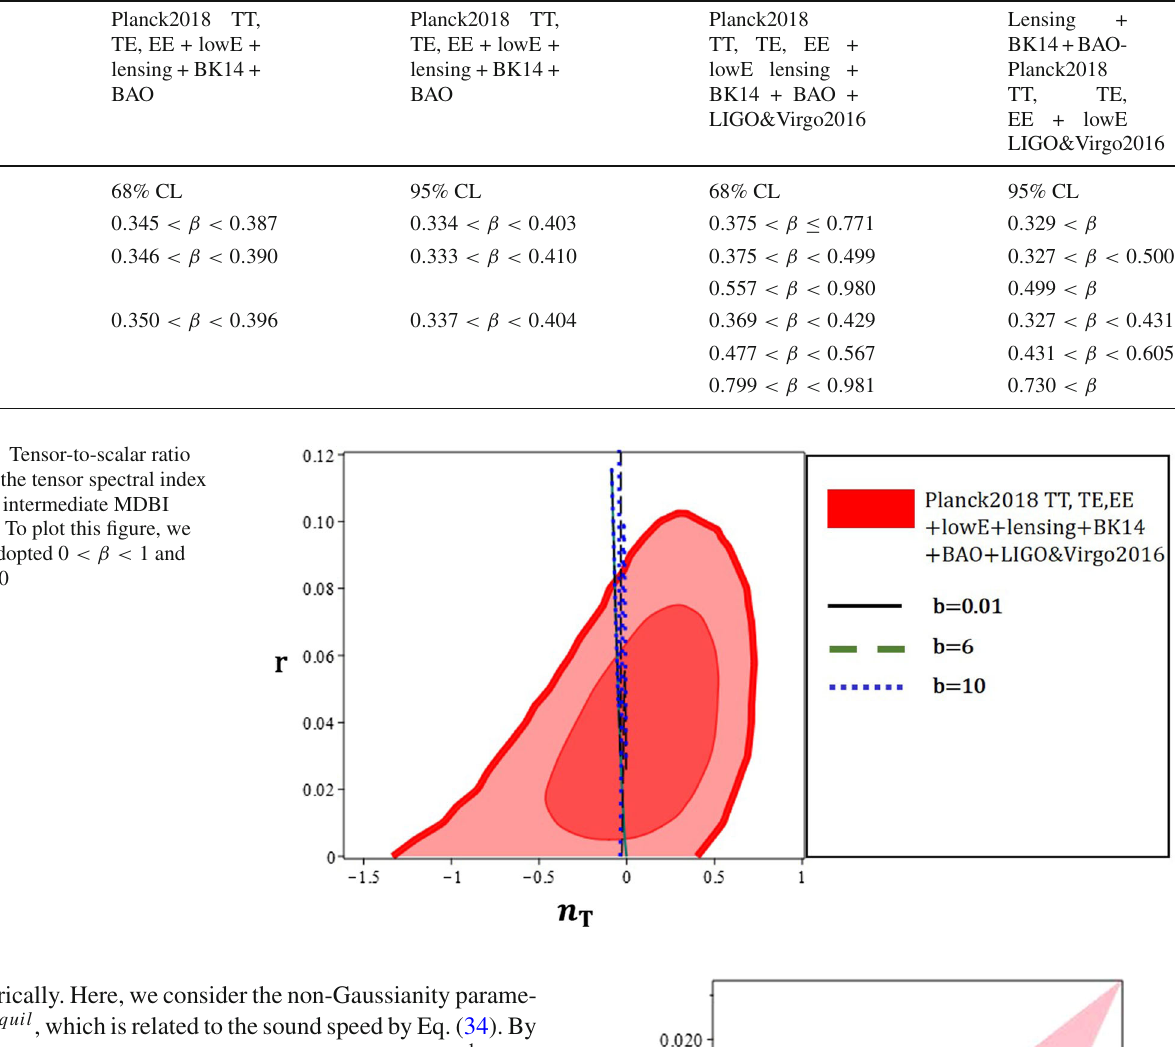
Table 1 The ranges of the parameter β in which the tensor-to-scalar ratio, the scalar spectral index, and the tensor spectral index of the intermediate MDBI model are consistent with different data sets